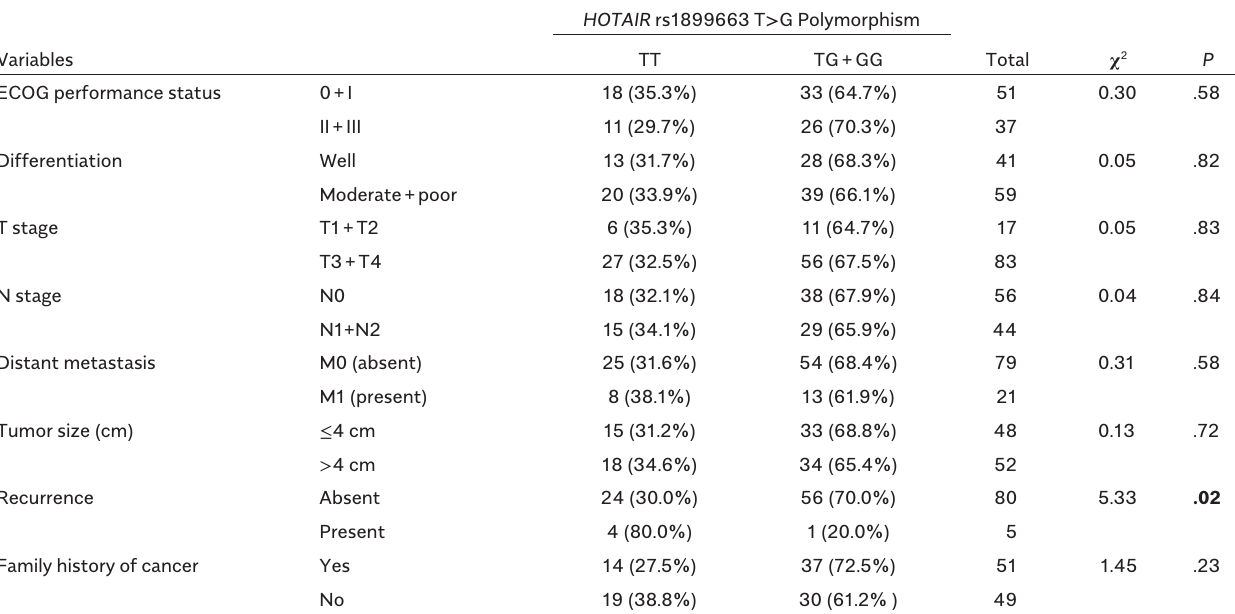
Table 3. Genotype Distribution of HOTAIR rs1899663 T > G Polymorphism Concerning Clinicopathological Features of Colorectal Cancer